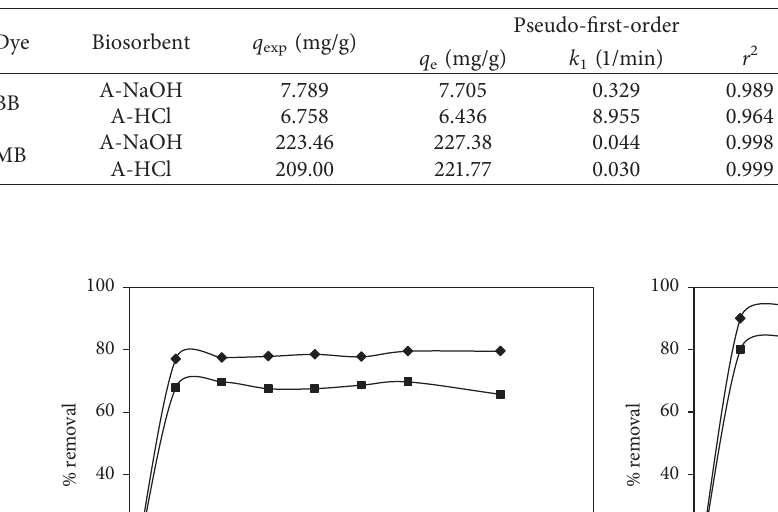
Table 2: Pseudo-first-order and pseudo-second-order kinetic parameters for the sorption of BB and MB onto A-NaOH and